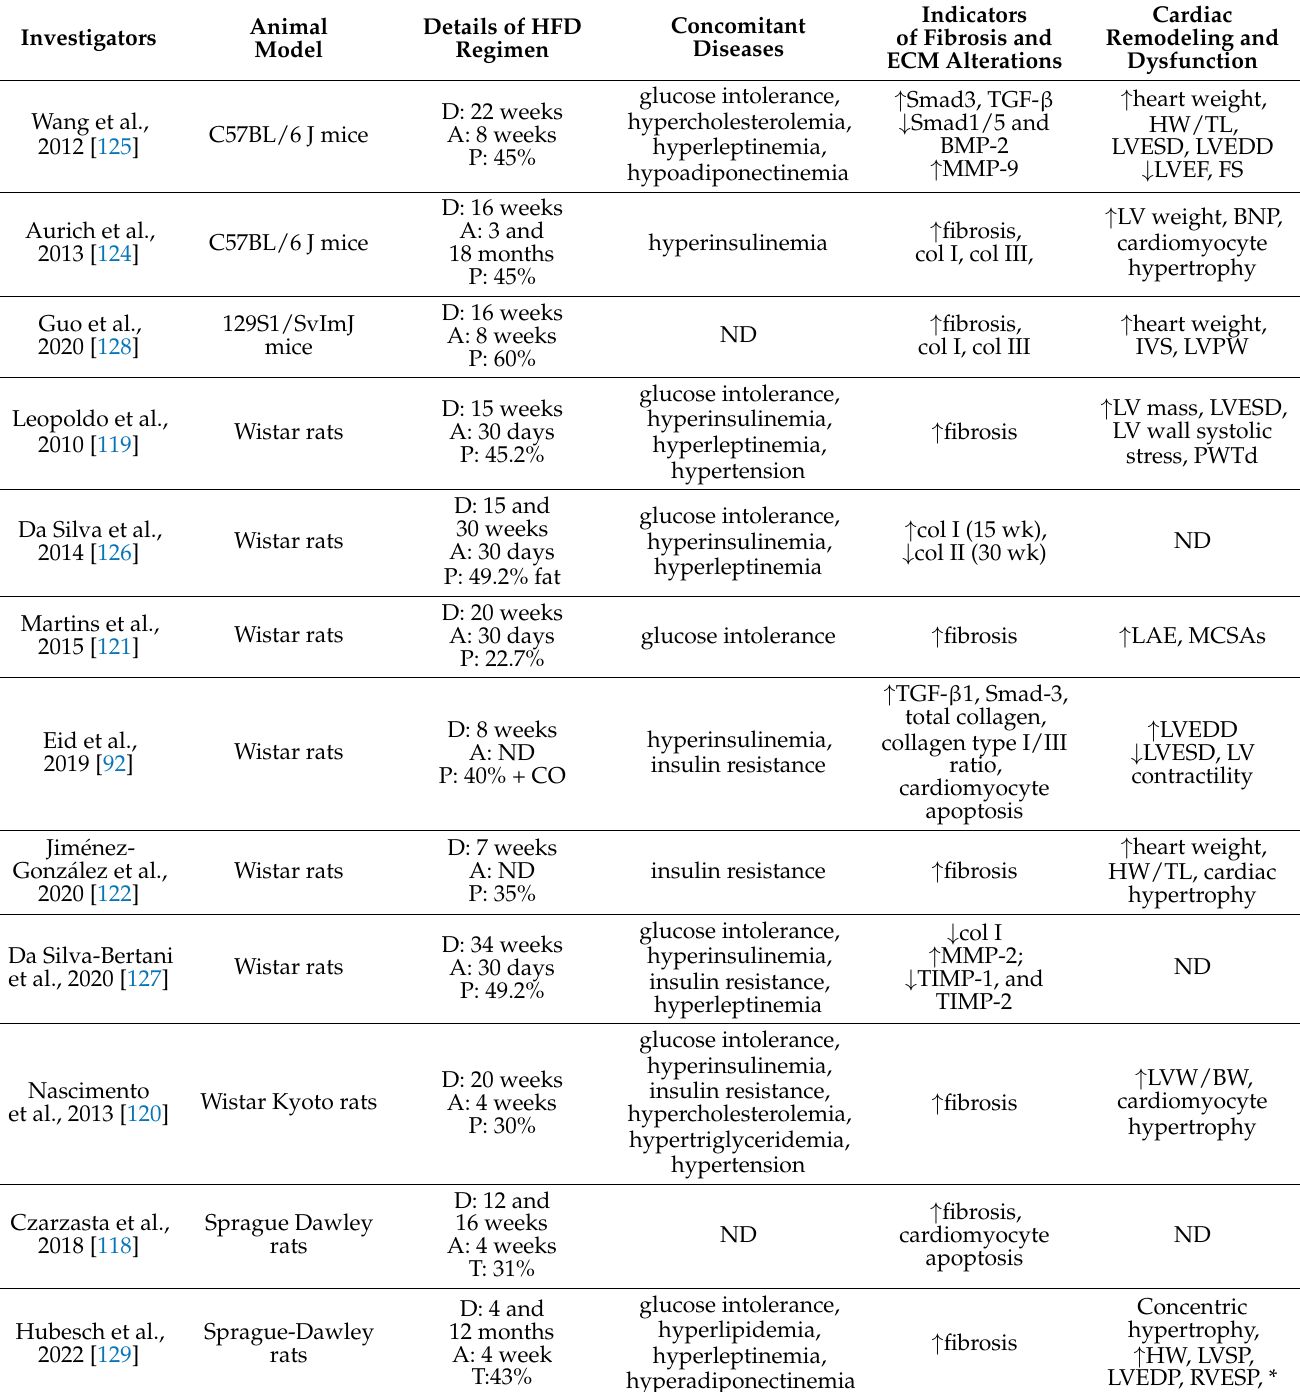
Table 1. Summary of studies performed on rodent models of high-fat diet (HFD)-induced